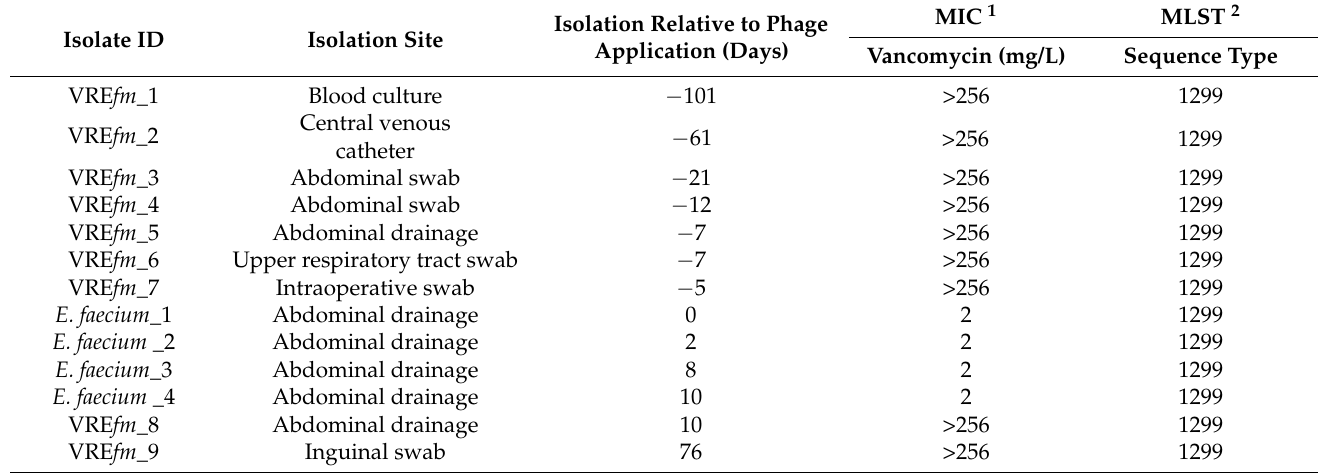
Table 1. VRE fm and E. faecium isolates identified before and after phage